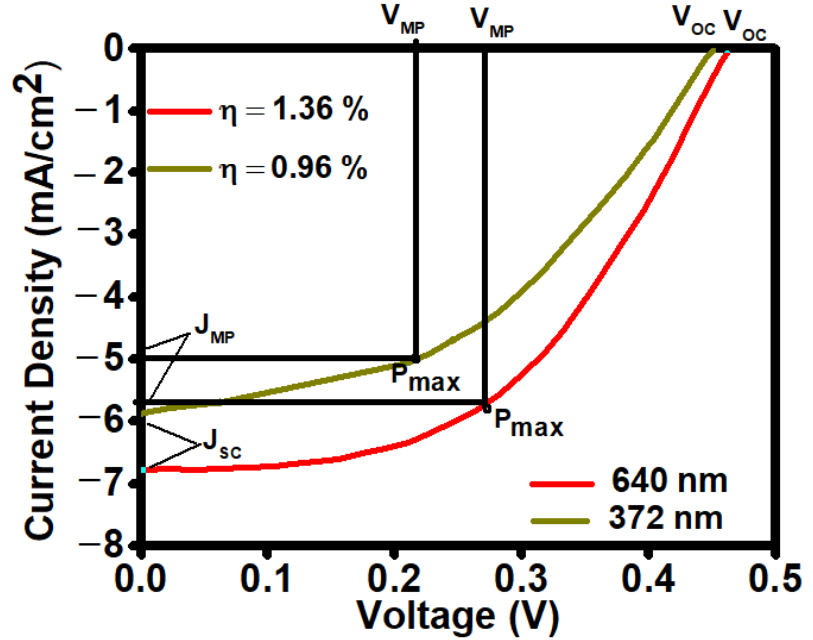
Figure 4. I–V plot for Sb 2 Se 3 /CdS-based structure with different absorber layer thicknesses.